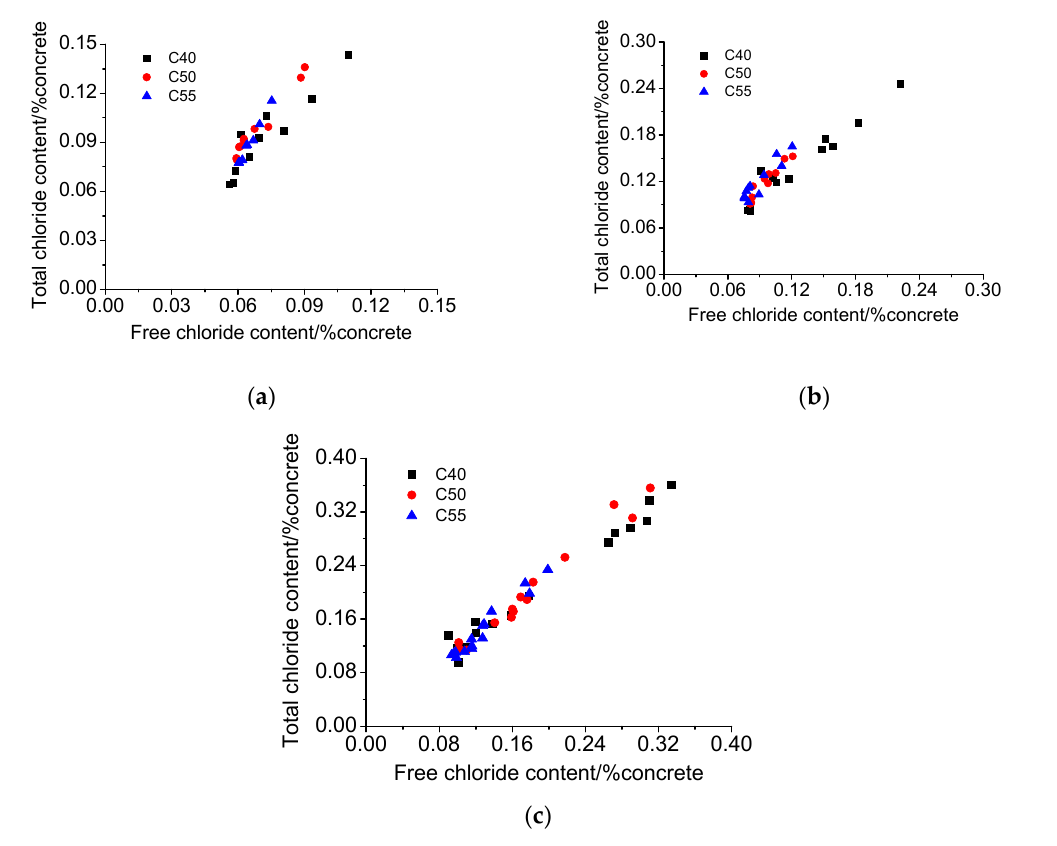
Figure 10. Chloride binding isotherms of C40, C50, and C55 exposed to the atmosphere zone after different times. ( a ) 1 month. ( b ) 3 months. ( c ) 9 months.